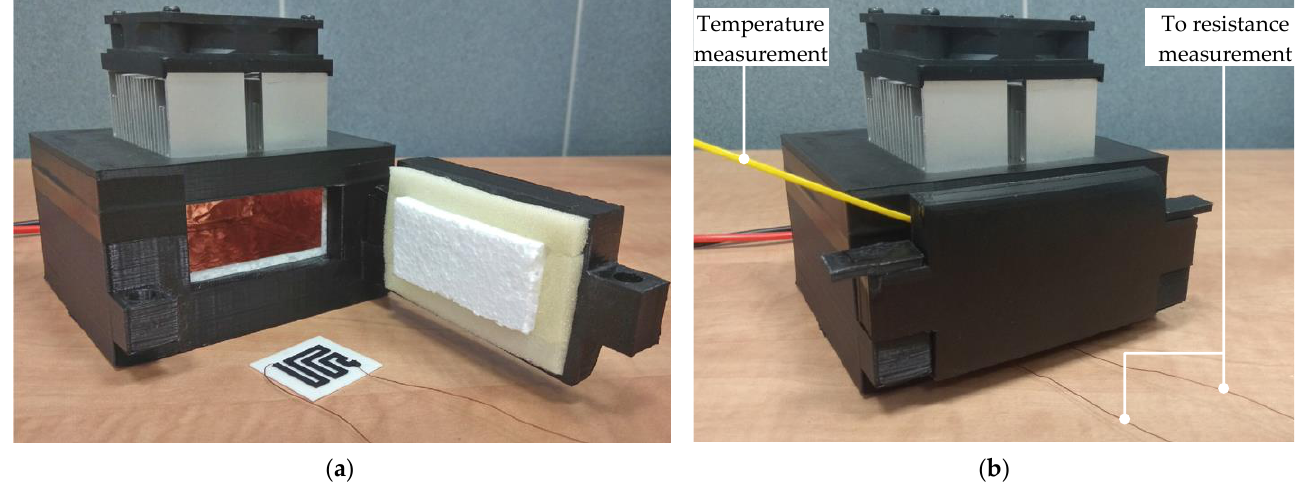
Figure 6. The miniaturized version of a temperature chamber used as an experimental stand: ( a ) a general view on the set and ( b ) the stand and samples prepared for the measurements.